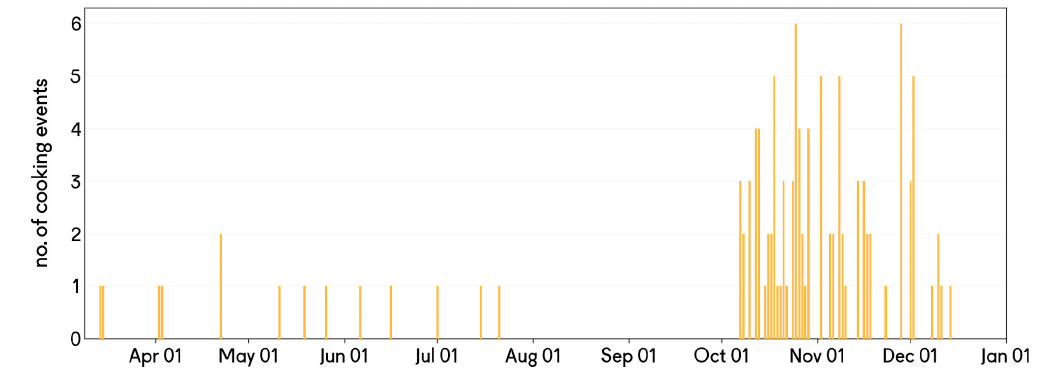
Figure 7. Daily EPC cooking events: high-usage user.